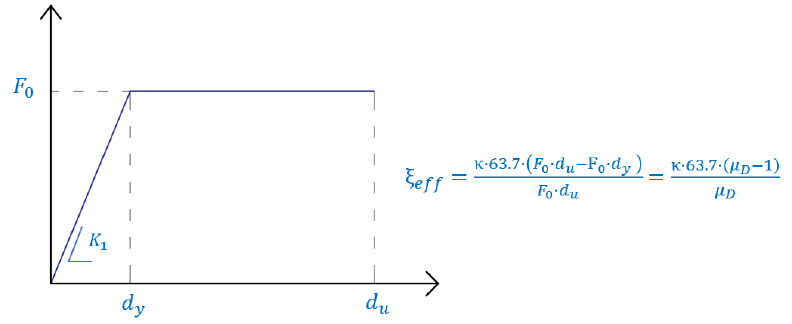
Figure 14. Force – deflection diagram of a single brace equipped with the PS-LED.